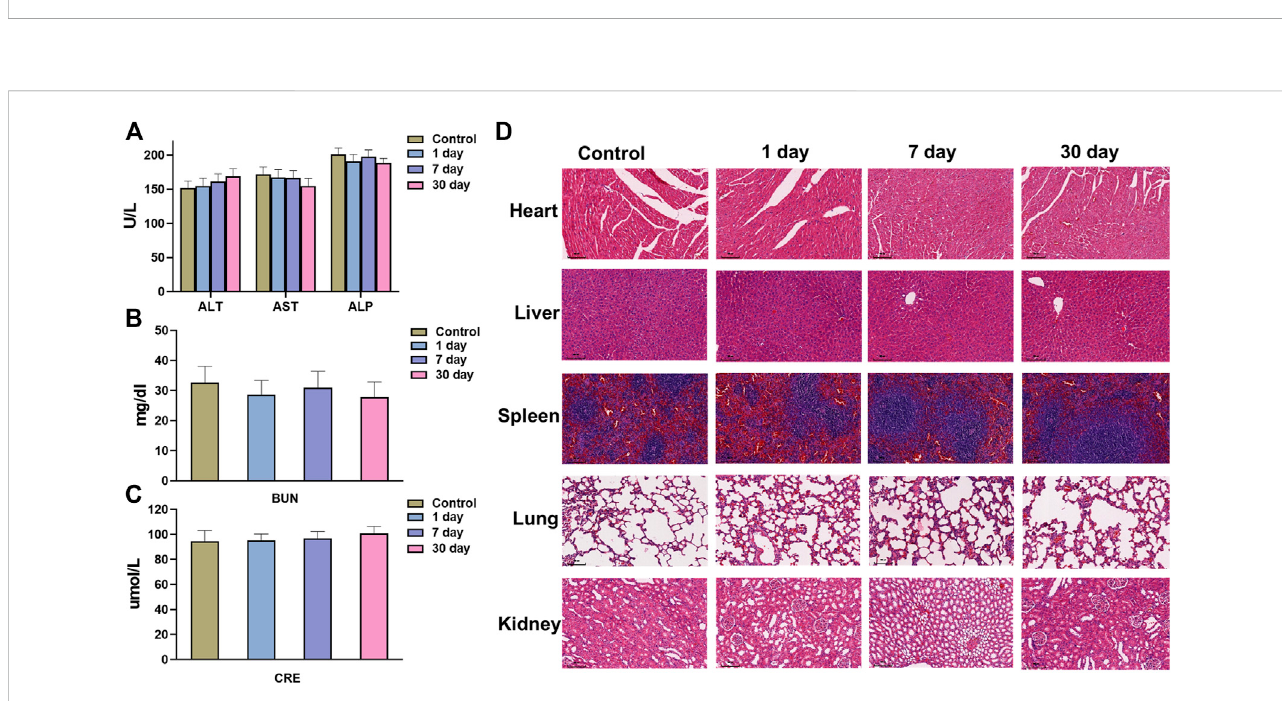
FIGURE 7 (A) Statistical plot of tumor volume; (B) Body weight chart of treated mice; (C) tumor imaging; (D) HE staining. Scale bars = 100 μ m for HE staining. HE, Hematoxylin-eosin